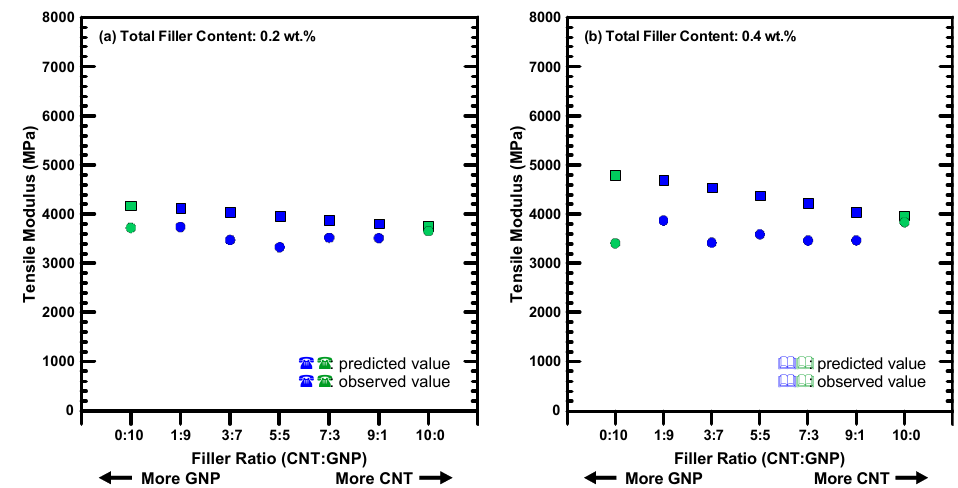
Figure 7. Comparison between the observed data and the predicted results for the tensile moduli of the nanocomposites with different filler ratios.